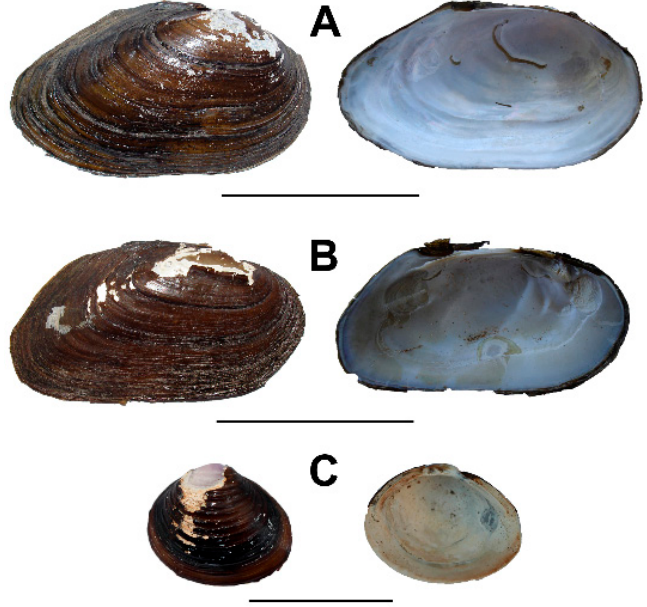
Figure 7. Shell form for the three modern Archanodon catskillensis proxies studied here. ( A ) Pyganodon cataracta . Scale bar = 7 cm; ( B ) Elliptio complanata . Scale bar = 5 cm; ( C ) Corbicula fluminea . Scale bar = 3 cm.